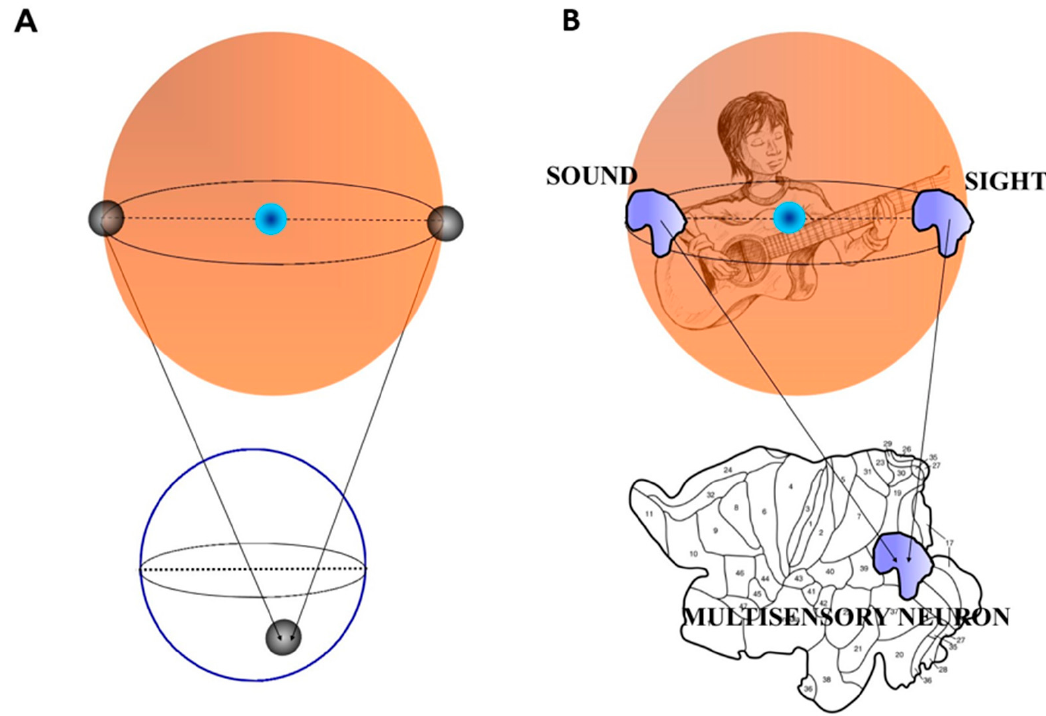
Figure 1. ( A ) A simplified sketch of the Borsuk-Ulam theorem: two antipodal points (black spheres) on a three-dimensional sphere project to a single point on a two-dimensional circumference. ( B ) The Figure shows what happens when an observer is in front of a guitar player. The environmental inputs from different sensory modalities (in this case sound and sight are depicted in guise of shapes instead of points) converge on a single group of multisensory neurons in the cortical layers of brain’s observer. Note that the brain is flattened and displayed in 2D [39]. According to the dictates of the Borsuk-Ulam theorem, the single shape contains a melted message from the two modalities. Modified from Tozzi and Peters [37].